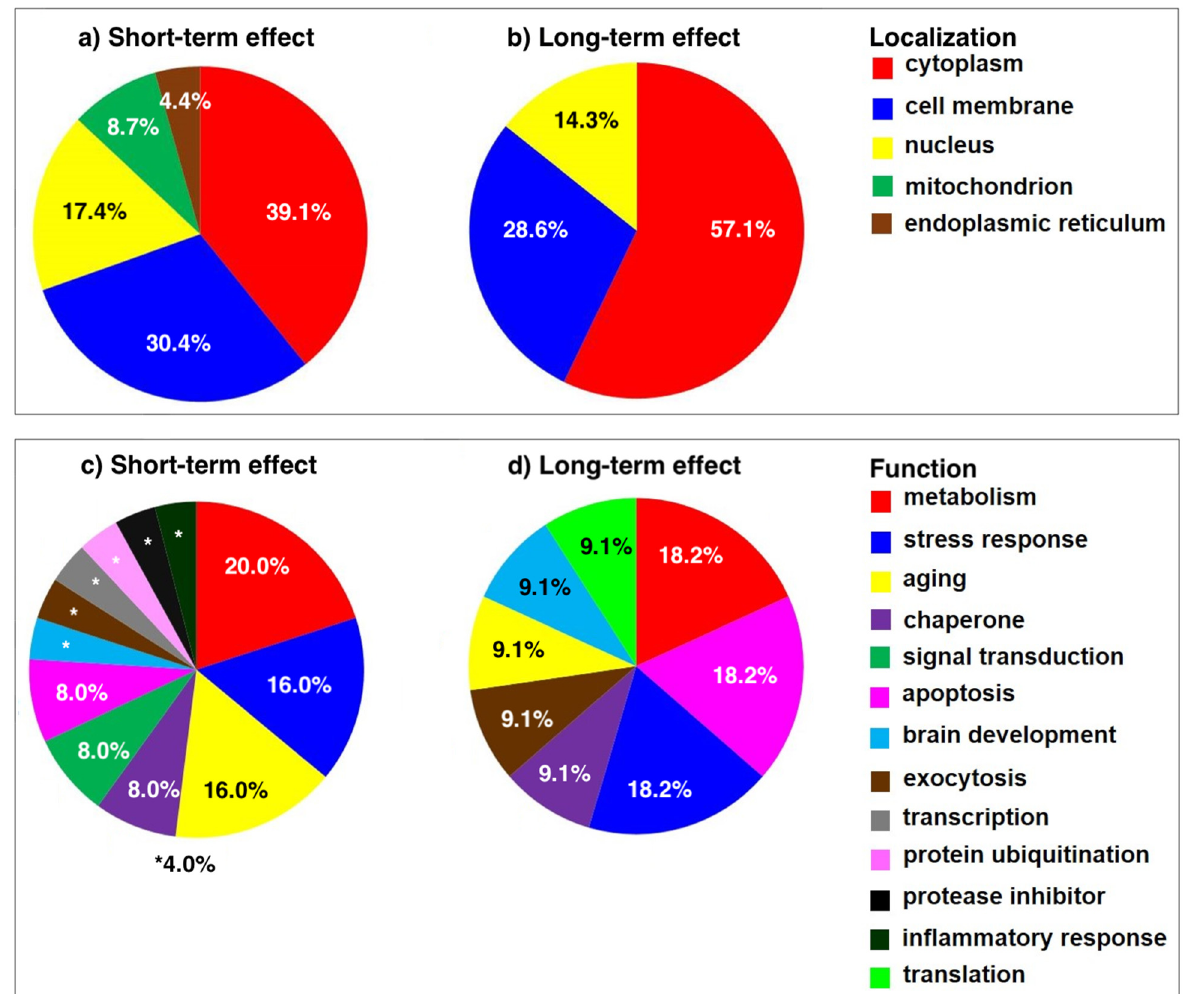
Figure 3. Subcellular localization ( a , b ) and functional significance ( c , d ) of the proteins upregulated in the mPFC of SNL rats compared to sham-operated rats at 2 weeks ( a , c ) and 8 weeks ( b , d ) post